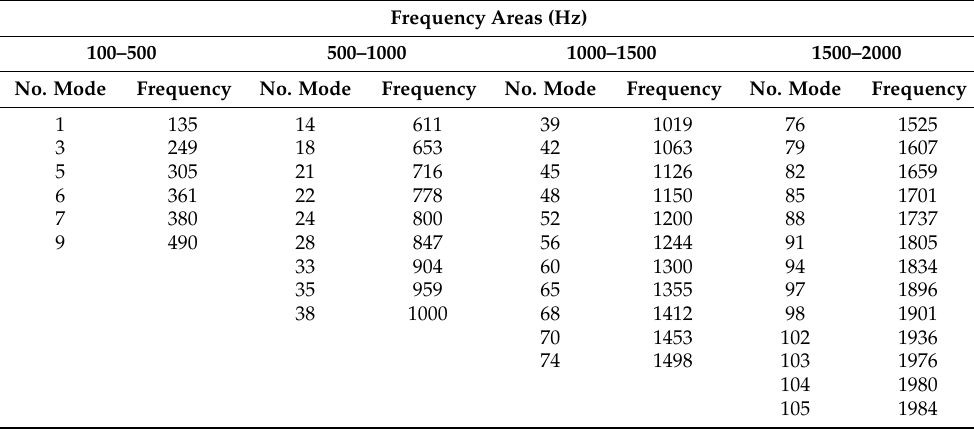
Table 2. Some of the calculated eigenfrequencies.